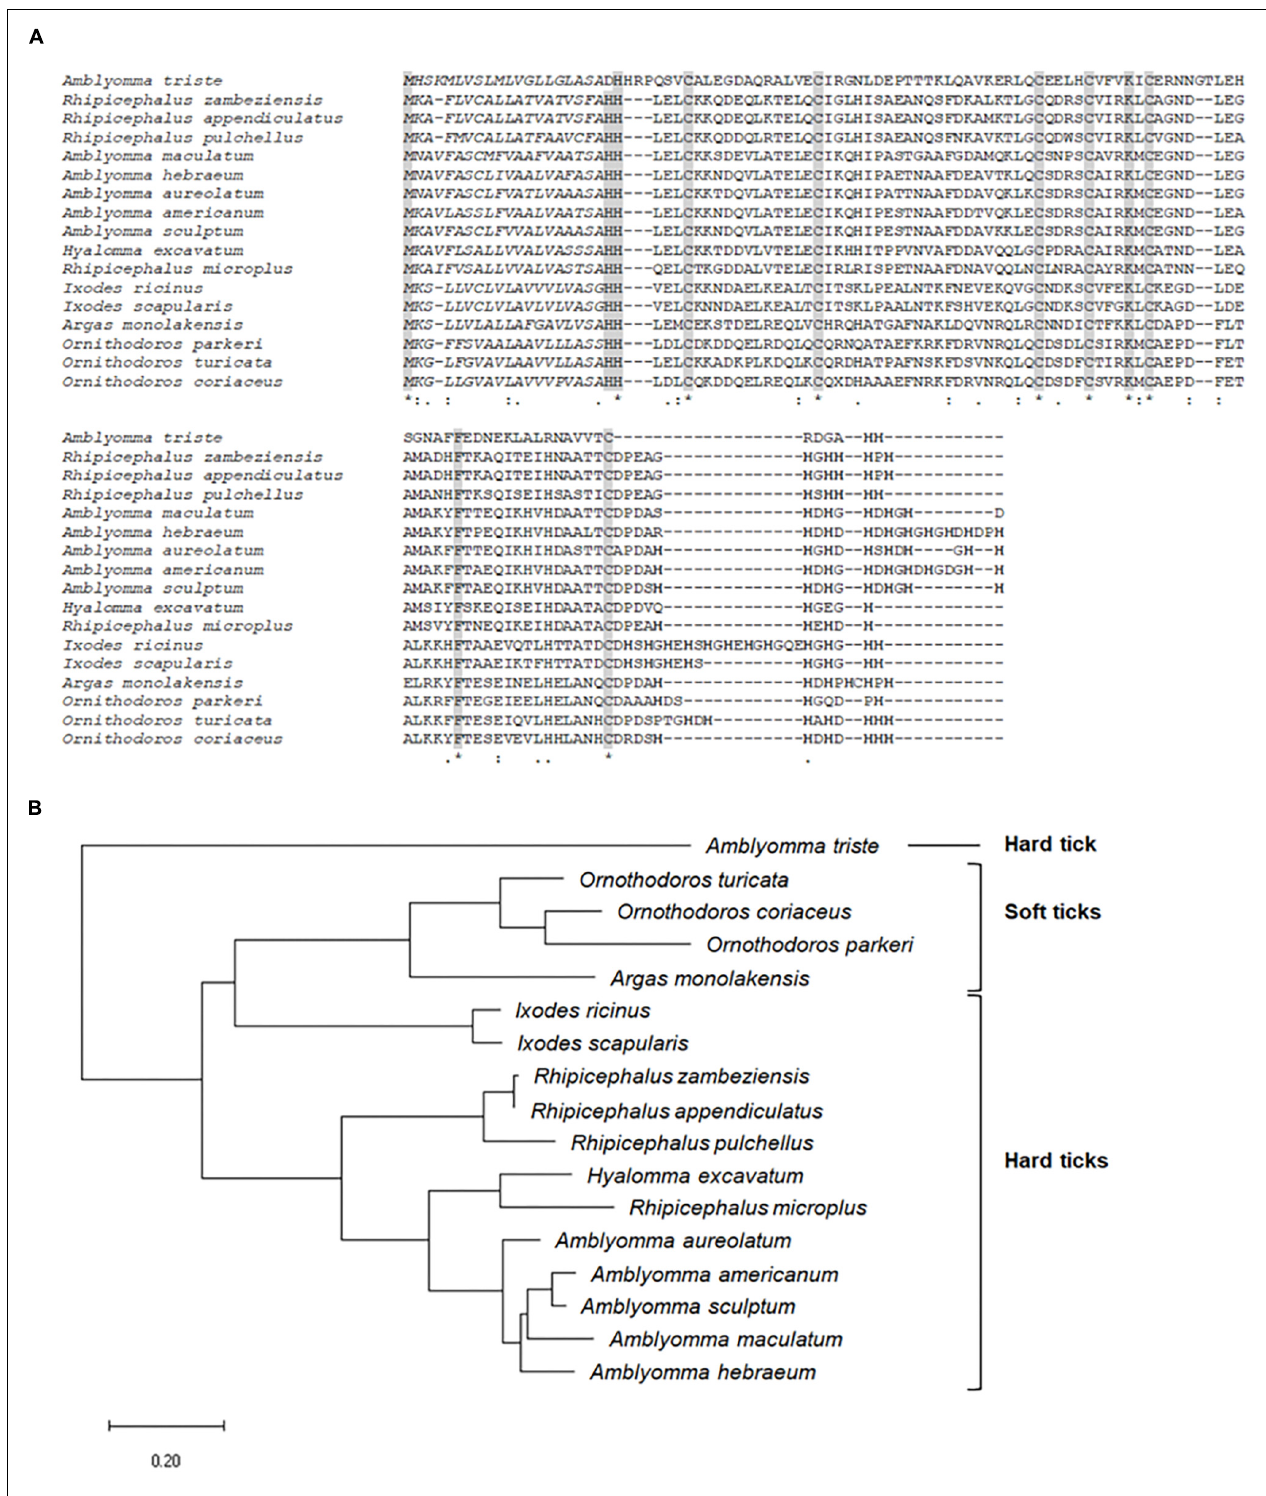
FIGURE 3 | MSA and phylogenetic analysis of microplusins. (A) Multiple sequence alignment of protein sequences was performed using MUSCLE method. Asterisks highlight the conserved cysteine residues; italic letters show the signal peptide; bold letters indicate histidine residues in the C-terminal. (B) A phylogenetic tree was constructed with protein sequences using Maximum Likelihood (ML) method. The analysis involved 17 amino acid sequences (accession numbers available in Supplementary Table 2 ). Bar scale at the bottom indicates 20% amino acid divergence.